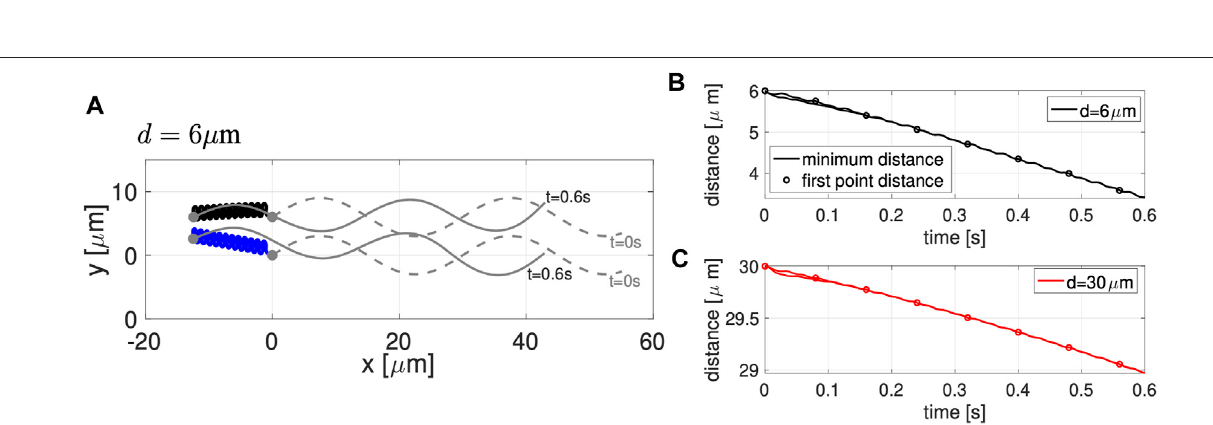
Frontiers in Physics |